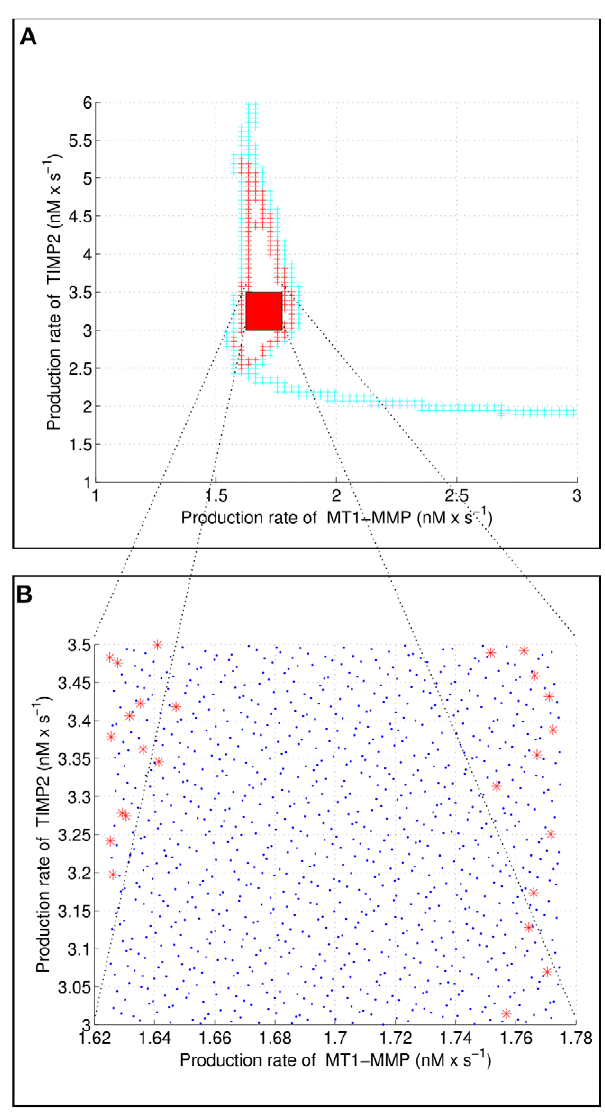
Figure 11. Assessing the robustness of oscillations. On A , we extracted a subset of the region where the oscillatory regime is observed and augmented it with uncertain parameters. B We sampled the resulting parameter space with 1000 quasi-random samples. The blue dots and the red stars correspond to parameter values generating oscillatory and non oscillatory trajectories, respectively. Only 25 out of the 1000 sample trajectories do not exhibit oscillations.